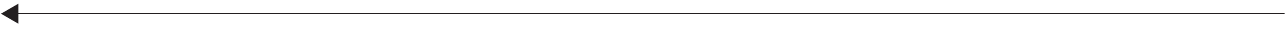
Fig. 1 Culture in rotating wall vessel conditions affects mesenchymal stem cell differentiation: a C3H10T1/2 cells were cultured 2 days on plastic beads or mineralized plastic beads in α MEM media in order to promote cell proliferation. They were then induced 2 days in differentiation media (for adipogenesis (AD) orosteogenesis (OB) with or without 5 mM strontium) before being cultured in simulated- microgravity condition or kept in static control condition in plastic dishes. Extraction of aggregates were realized in order to perform Oil Red O staining ( b ), ALP staining ( c ), RT-quantitative PCR, ELISA and G-Lisa at days 0, 2, 6 and 8 for rotating condition and at days 0, 2 and 8 for static control condition. Each condition was repeated three times independently. Adipogenic [ b : peroxisome proliferator-activated receptor γ (PPAR γ ), CCAAT-enhancer-binding proteins α (C/EBP α ), fatty acid-binding protein (FABP4) and adiponectin] and osteogenic [ c : alkaline phosphatase (ALP), osterix (OSX), bone sialoprotein (BSP) and osteopontin (OPN)] gene expressions were measured by RT-quantitative